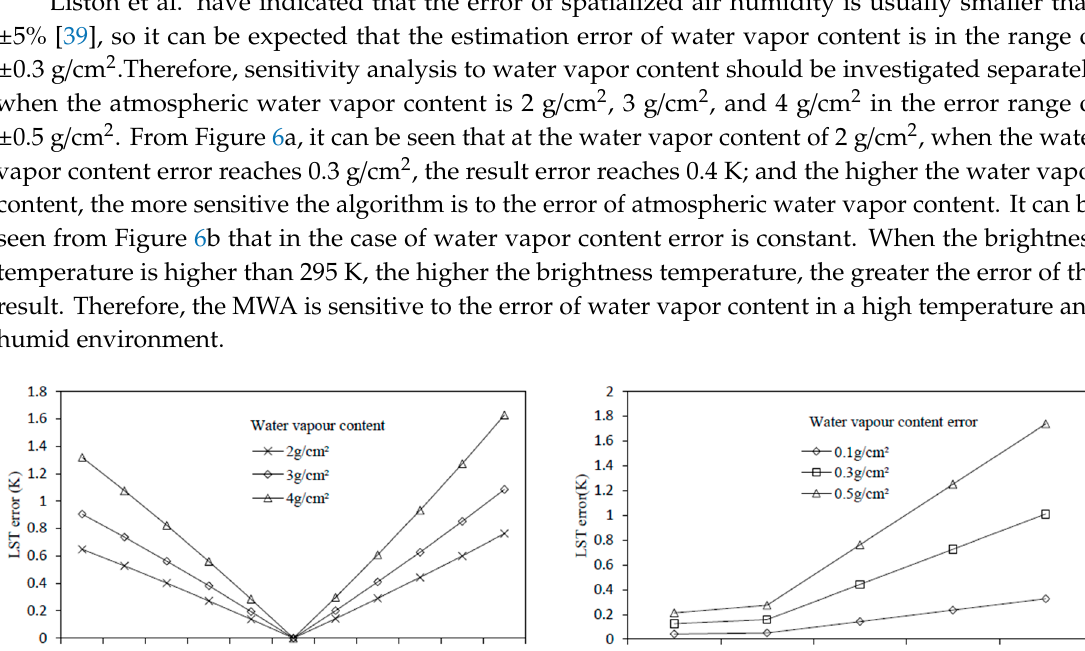
Table 7. The ratio of D (cid:2869)(cid:2868) C (cid:2869)(cid:2868) ⁄ in the case of different LSE (Land surface emissivity) and transmission.